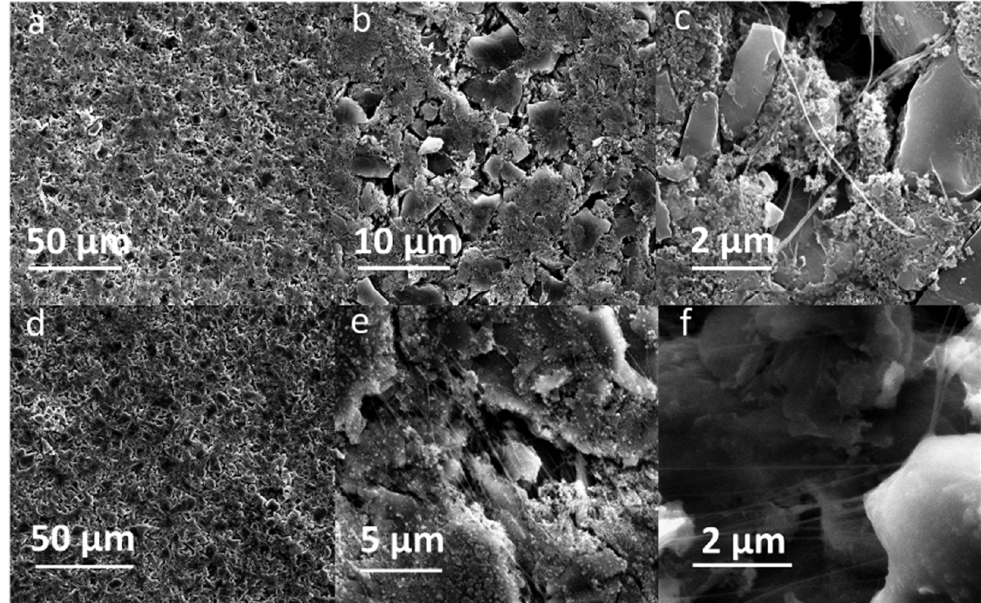
Figure 7. SEM images of pristine SF hard carbon anodes with different magnifications: ( a ) 1550×, ( b ) 7200, and ( c ) 33,000×. SF hard carbon anodes after 100 cycles with different magnifications: ( d ) 1550×, ( e ) 16,000×, and ( f ) 33,000×.